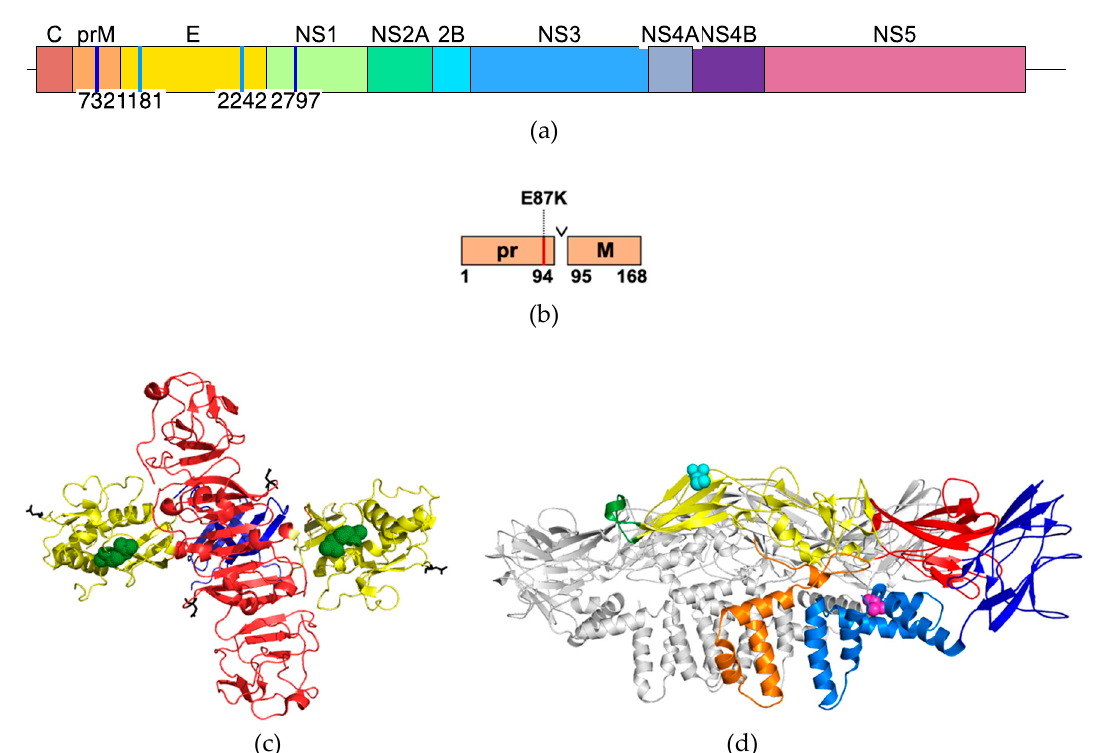
Figure 4. Location of amino acid substitutions incurred after HeLa cell passage . ( a ) ZIKV genome organization showing the non-synonymous nucleotide changes occurring after in vitro HeLa cell passaging at positions 732 and 2797 (dark blue vertical lines), and after in vivo mouse passaging of HeLa-P6 at 1181 and 2242 (light blue vertical lines). ( b ) Cartoon representation of the location of prM amino acid 87 in the pr peptide domain, which is cleaved by furin protease during maturation. ( c ) Top view of the NS1 protein dimer structure [9] shows the location of residue 103 (green spheres) in the wing domain (yellow). ( d ) Side view of of the cryo-EM [10] of three M–E proteins showing E 68 in cyan in domain 2 and E 422 in magenta in the stem region. One M and one E protein are shown in color (red—E domain 1, yellow—E domain 2, green—fusion loop, dark blue—E domain 3, marine blue—E stem and transmembrane, orange—M transmembrane). Other synonymous nucleotide substitutions were detected but were not shared among the tissue sample sequences (Table 2). Virus recovered from the brain tissue of one mouse infected with HeLa-P6 virus reverted and did not contain any amino acid substitutions common to the HeLa-passaged viruses, but, rather, contained three unique amino acid substitutions at E N207K, NS1 M349K, and NS3 A88T (Table 2). By comparison, three brain and three testis samples were sequenced from WT-ZIKV-infected AG129 mice. The virus sequences were identical to the parent unpassaged virus, with the exception of one common amino acid substitution of NS2A A117V (six of six samples) (Table 2). One unique synonymous nucleotide substitution was detected in the testis sample from a WT-ZIKV-infected mouse (Table 2). In summary, the two amino acid substitutions identified in the HeLa-P3–P6 viruses were retained in a majority (six of seven) of the HeLa-P6-infected animal-derived samples, and two additional common amino acid substitutions were acquired in vivo. Taken together with the in vitro and in vivo results of HeLa-passaged ZIKV, the amino acid substitutions at prM E87K and NS1 R103K may have contributed to the attenuation of ZIKV in vitro and in vivo, however, the role of the additional common amino acid substitutions at E M68I and E A422V is less clear, as they may play a role in attenuation or virulence of ZIKV in